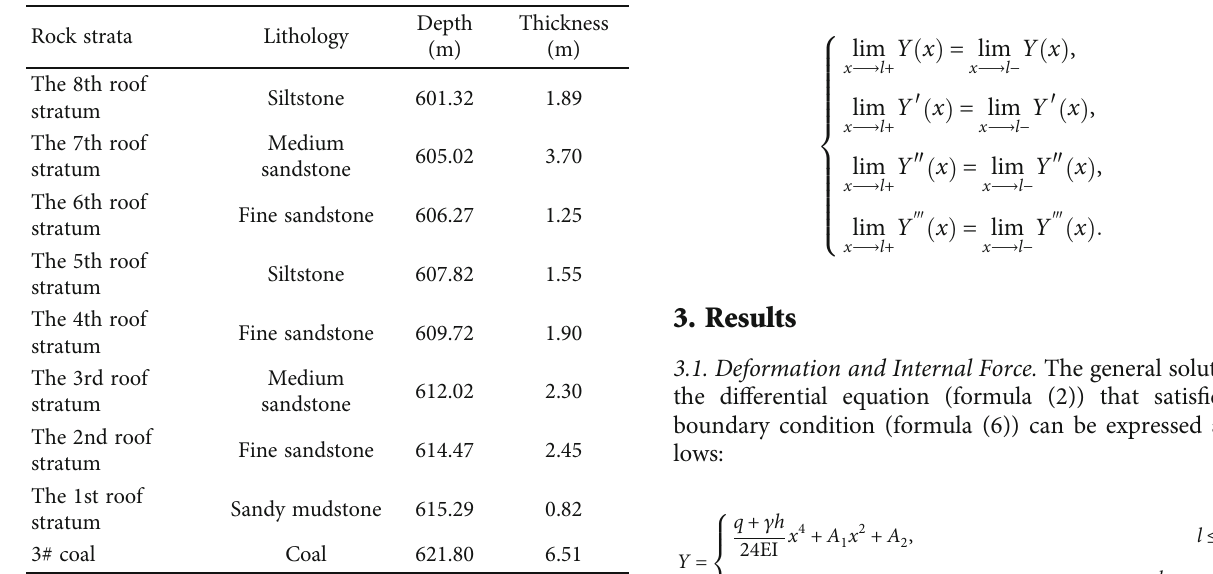
Figure 2: The analysis object of the composite beam and its force in the vertical direction. Table 1: Rock properties of the roadway roof strata.